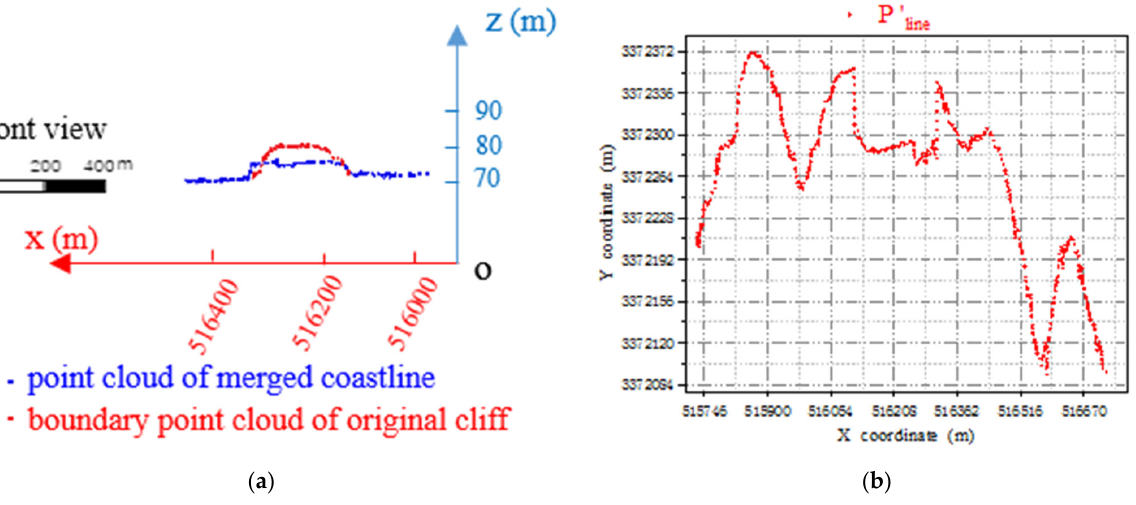
Figure 10. ( a ) Superposition of point cloud of optimal coastline and centroid and point cloud at cliff; ( b ) The enlarged view of the red box in Figure ( a ).